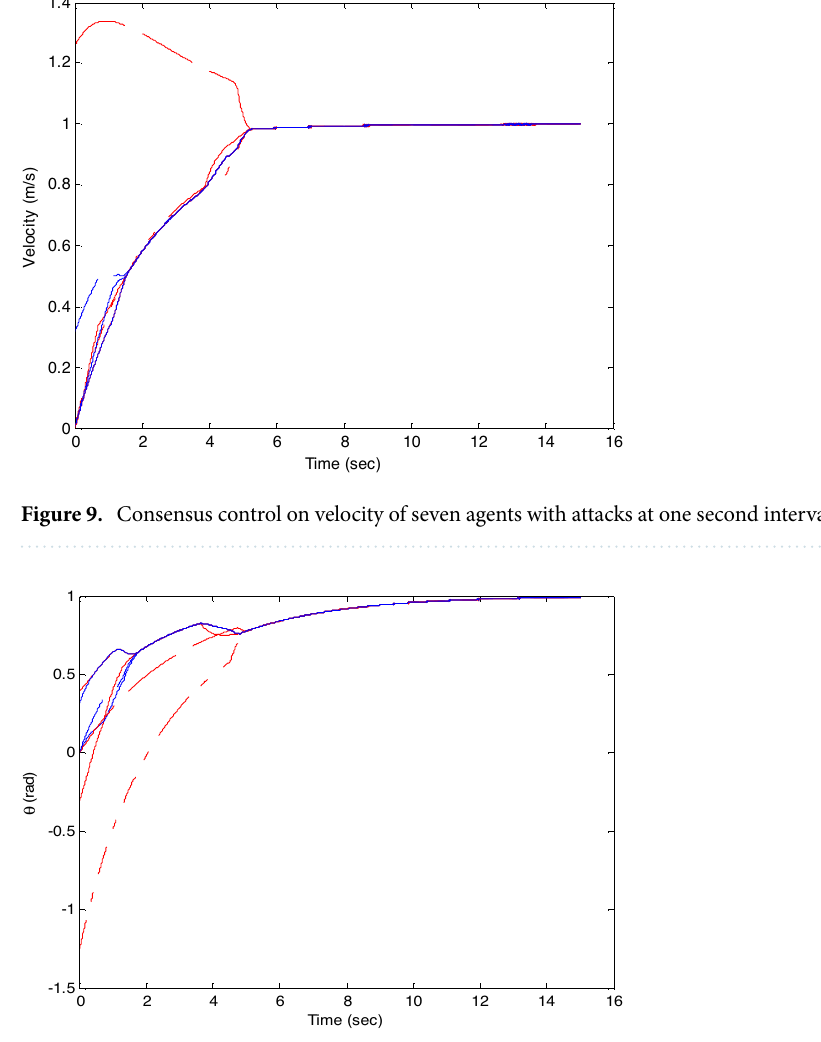
Figure 10. Consensus control on heading angle of seven agents with attacks at one second interval.